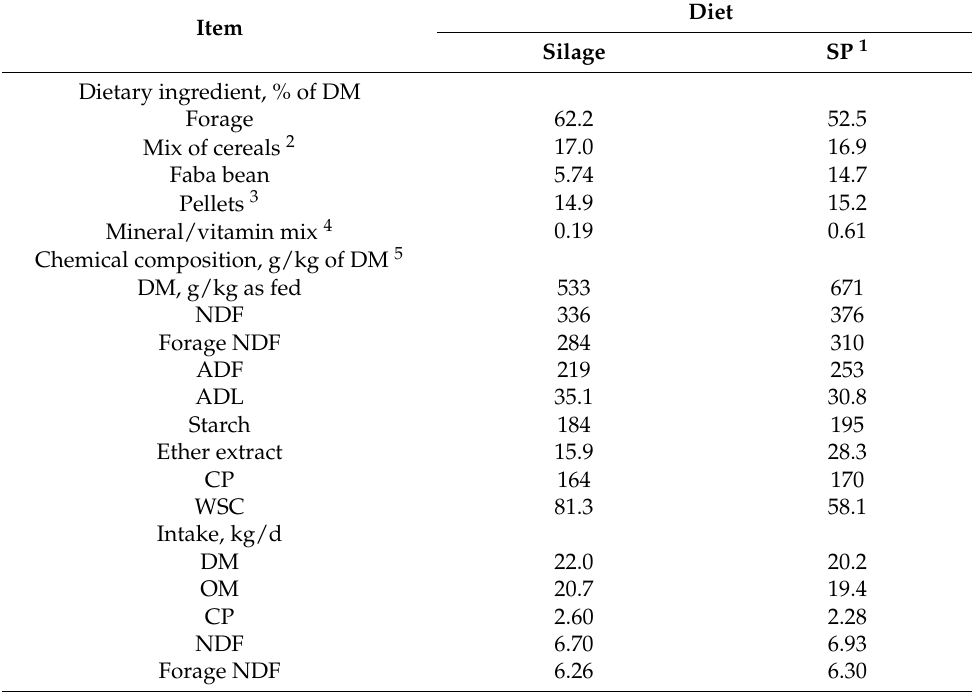
Table 2. Dietary ingredients, chemical composition and intake of the experimental